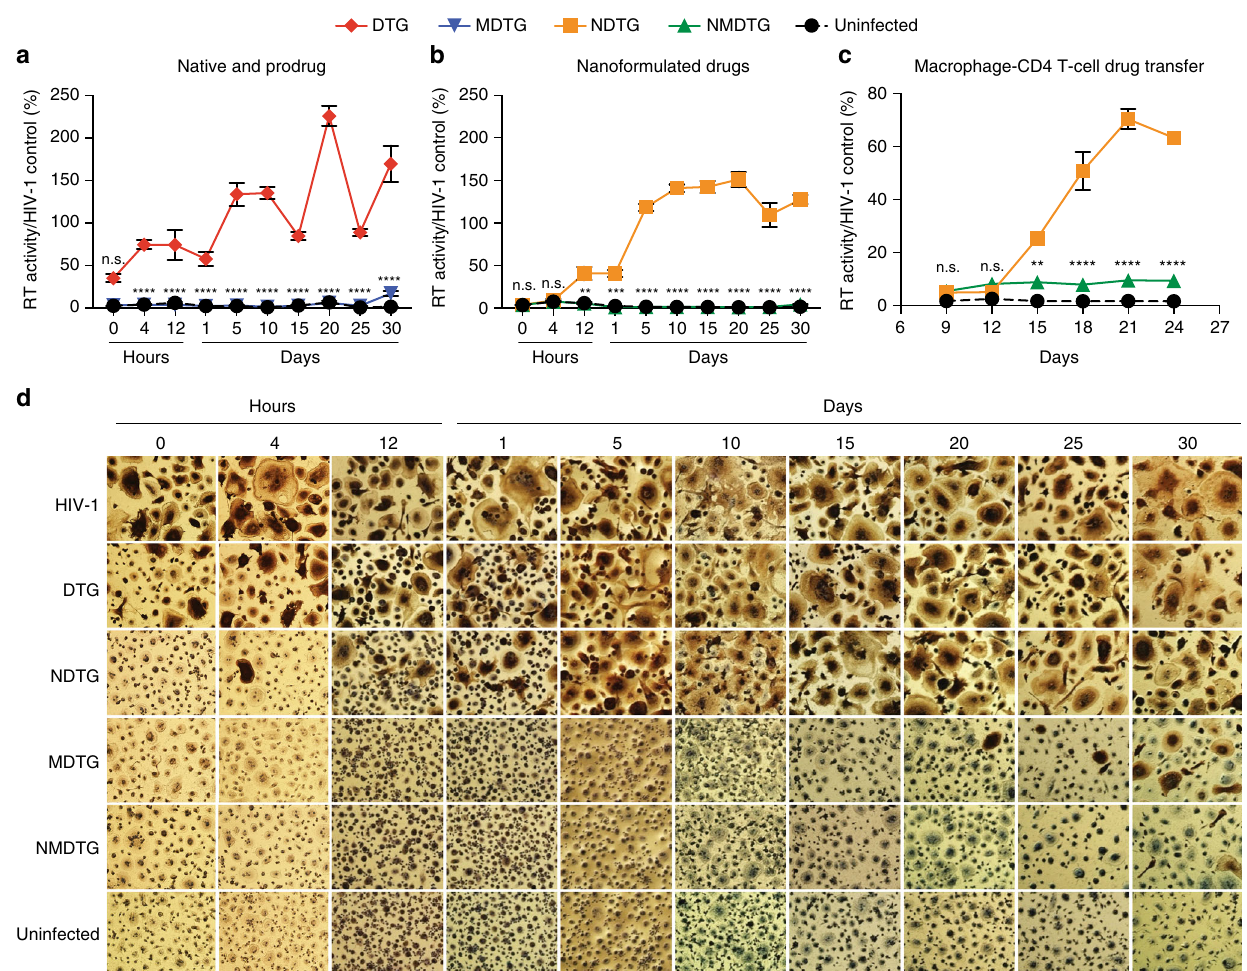
Fig. 4 Antiretroviral ef fi cacy. a , b HIV-1 RT activity of ( a ) DTG and MDTG, and ( b ) NDTG and NMDTG-treated MDM. ** P = 0.0039, *** P =